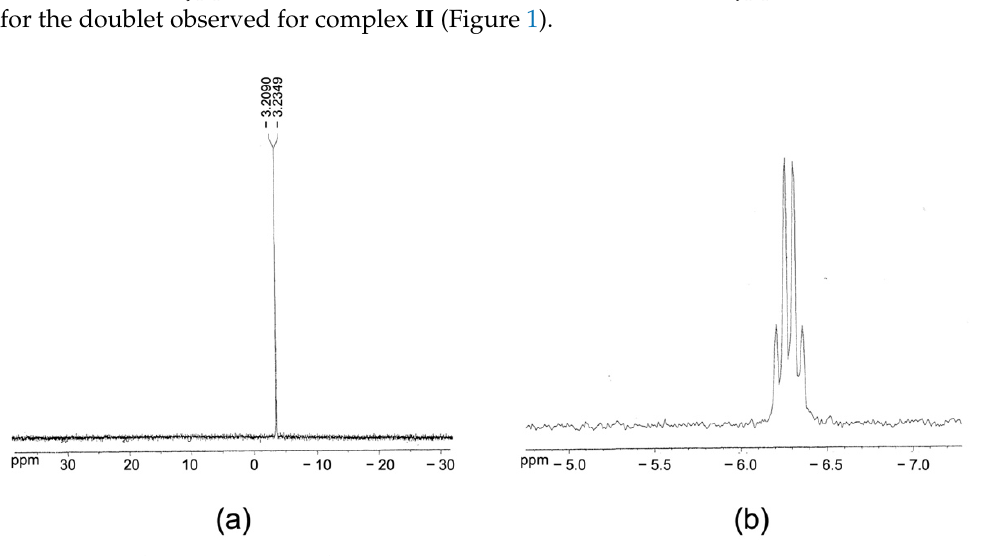
Figure 1. The 19 F NMR ( a ) and 31 P NMR ( b ) of complex II . Refer to the text for the analysis of the peaks and their ppm values.